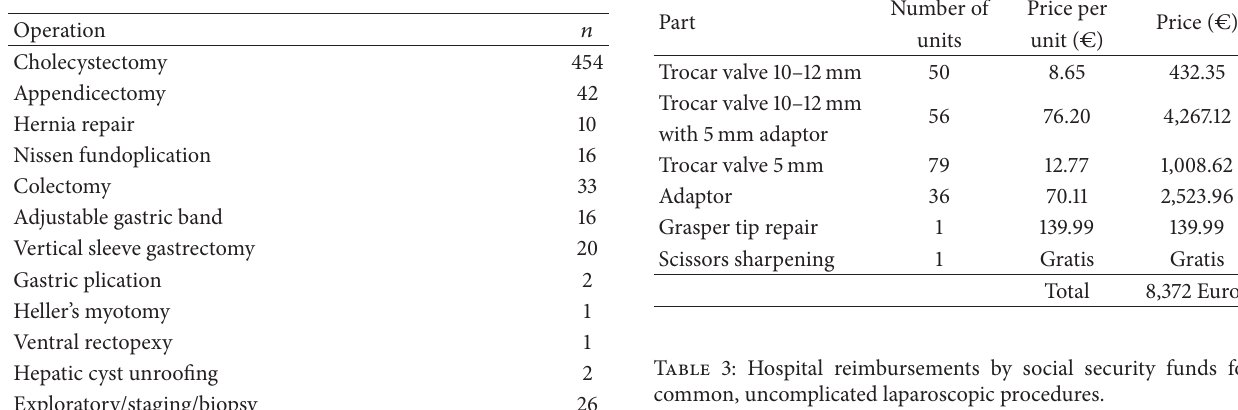
Table1:LaparoscopicoperationsbetweenJanuary2012andDecem- ber 2013.